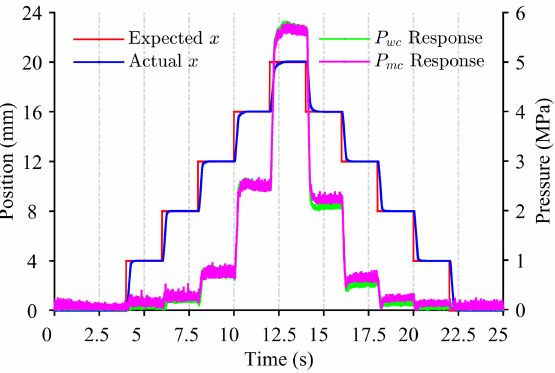
Figure 14. The test results of step wave input for the piston